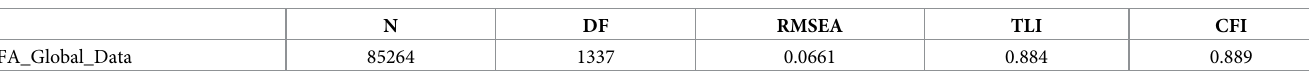
Table 3. Absolute fit values at global level for CFA model.